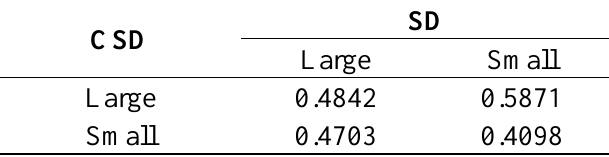
Table 2. Average BR in terms of CSD and